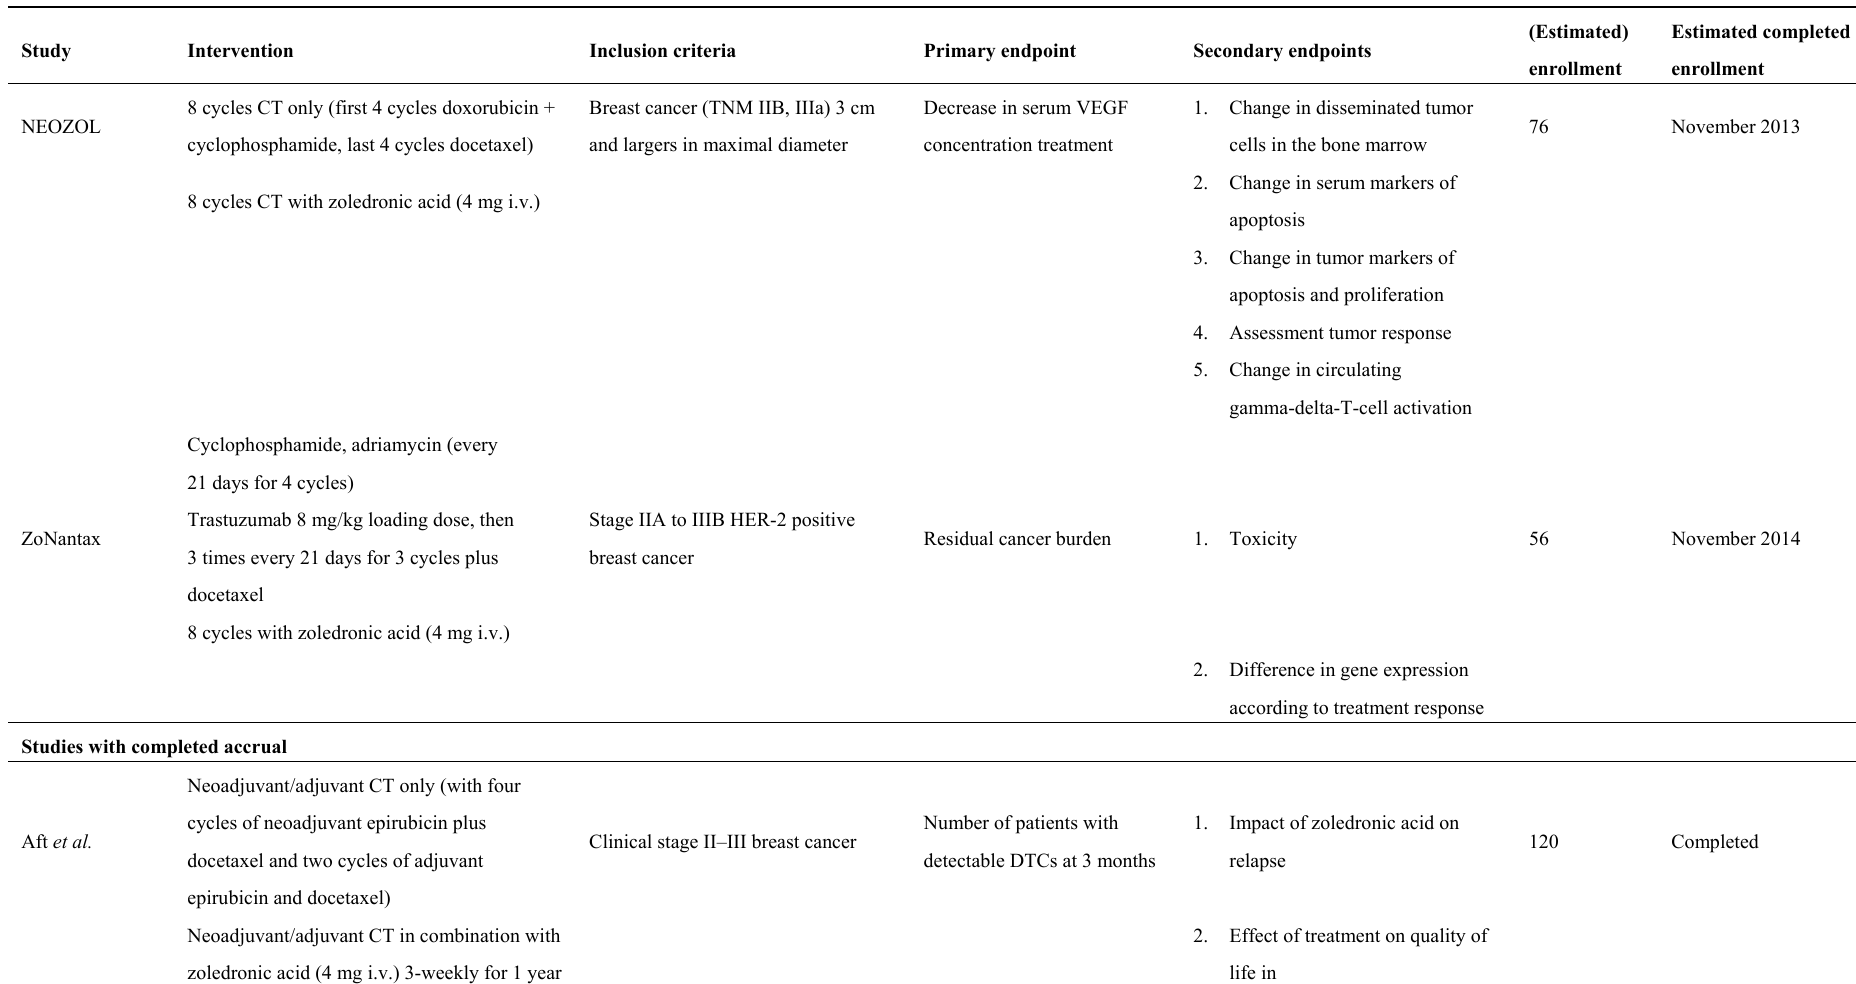
Table 1. Summary of neoadjuvant studies with chemotherapy in combination with zoledronic acid *